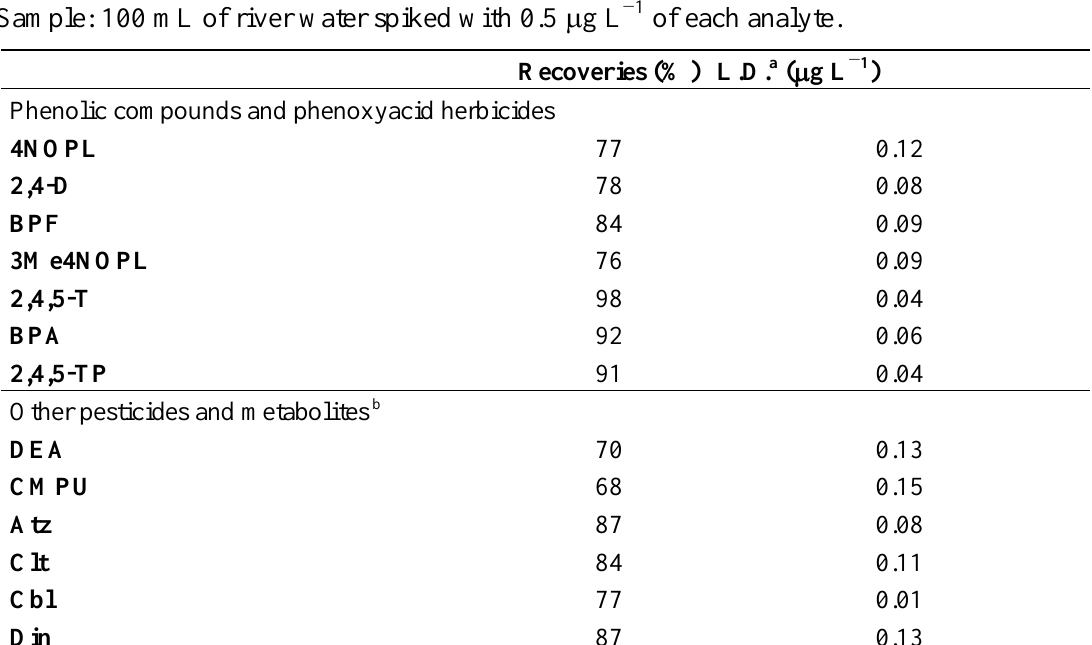
Table 3. Recoveries and limits of detection obtained for all the compounds studied.